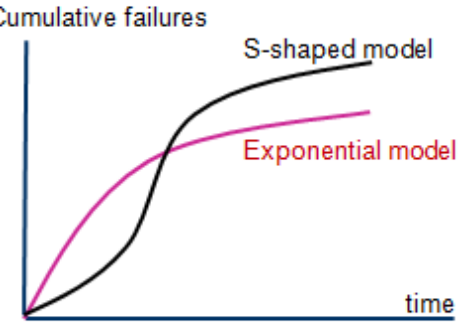
Fig. 1. Exponential Model and S-shaped Model